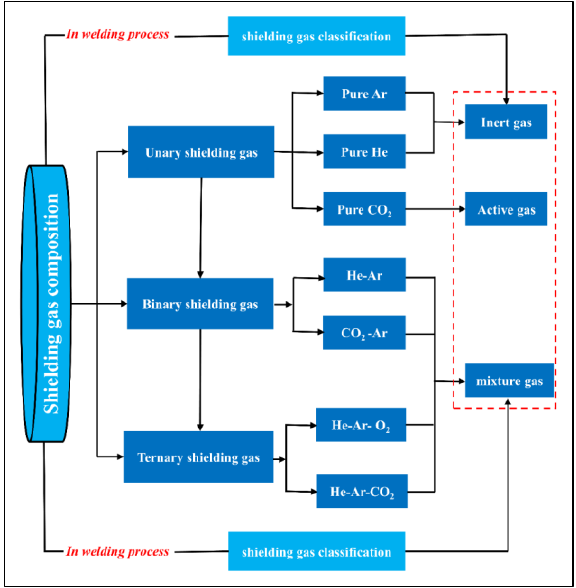
Figure 18. The flow chart of different shielding gases.